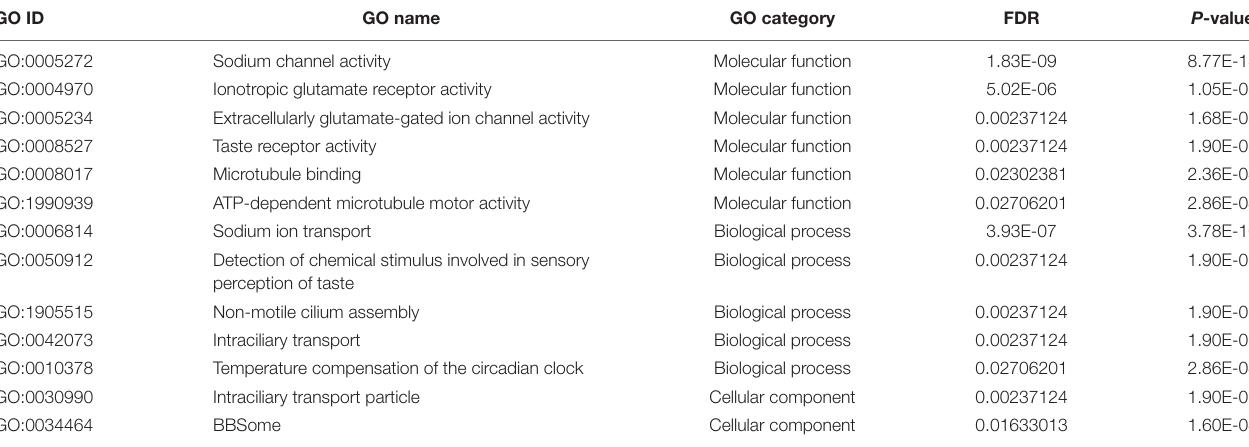
FIGURE 1 | Scanning electron micrographs of Tropilaelaps mercedesae sensory organ. (A) The foreleg with the numbered sensilla. (B) The second leg. (C) The third leg. (D) The fourth leg. (E) The pedipalp. (F) Sensillum #3 with a rough surface. (G) Sensillum #18 with a terminal pore. (H) Sensillum #8 with a smooth surface. (I) Sensillum #2 with surface pores of high density. (J) Sensillum #7 with surface pores of medium density. (K) Sensillum #10 with surface pores of low density. (L) Two sensilla at the distal end of pedipalp. A scale represents 50 µ m in the panels (A–E) , 2 µ m in the panels (I,K) , and 1 µ m in the panels (F–H,J,L) . TABLE 1 | GO terms enriched with genes highly expressed in the forelegs compared with hindlegs of T. mercedesae. GO ID GO